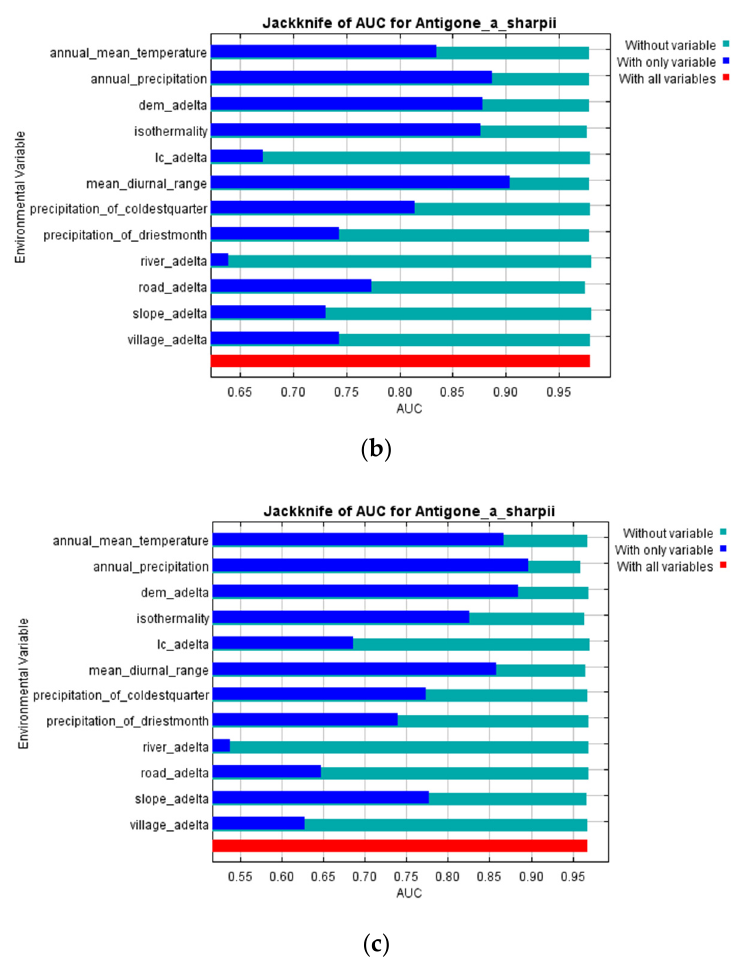
Figure 6. The Jackknife test for evaluating the relative importance of environmental variables for eastern sarus crane ( Antigone antigone sharpii ) in Ayeyarwady Delta, the Union of Myanmar in ( a ) the summer season, ( b ) the rainy season, and ( c ) the winter season.